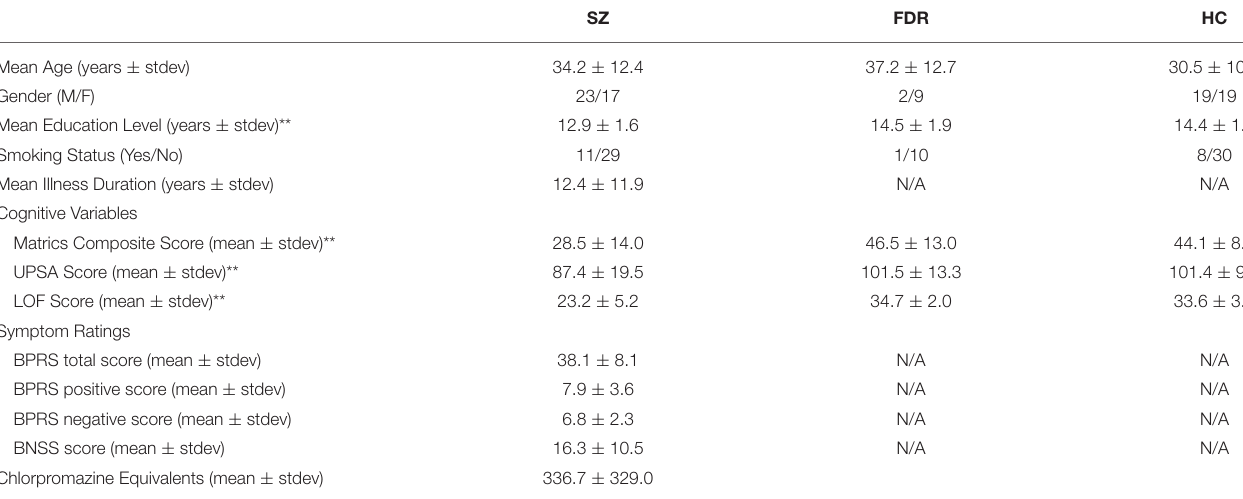
TABLE 1 | Participant demographics.